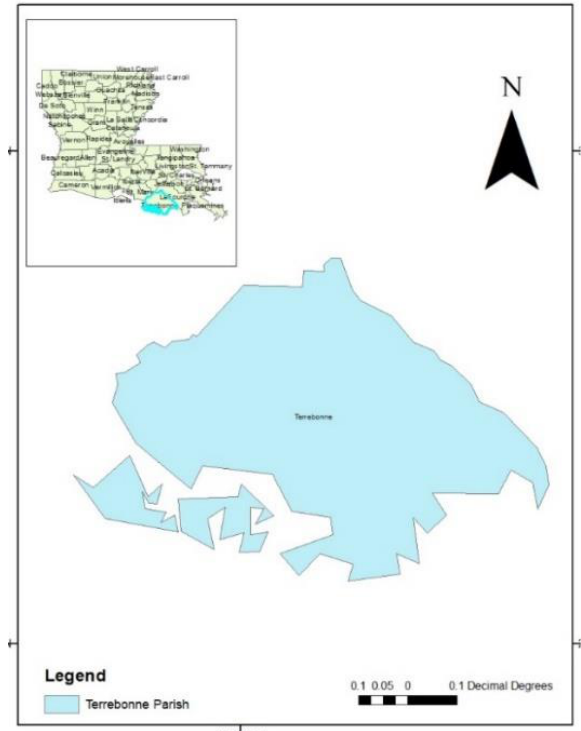
Fig.2 A map of Terrebonne Parish indicating the study